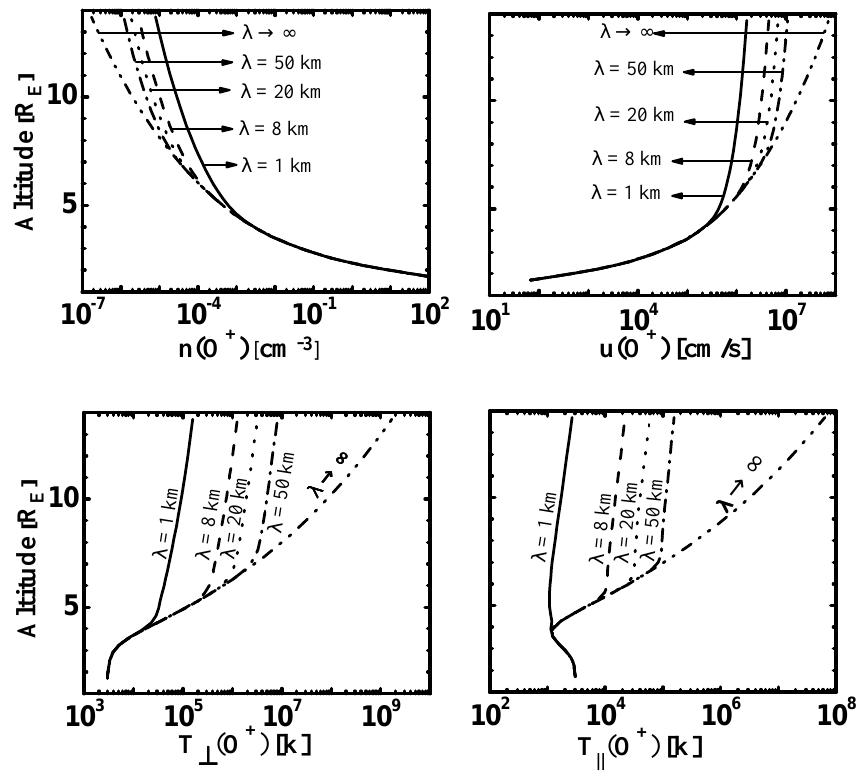
Fig. 3. Altitude profiles of the lower order O + moment for different electromagnetic turbulence wavelengths ( λ ⊥ ) . The wavelengths considered here are λ ⊥ → ∞ (double-dotted dashed line), λ ⊥ = 50km (dotted dashed line), λ ⊥ = 20km (dotted line), λ ⊥ = 8km (dashed line), λ ⊥ = 1km (solid line). The O + moments considered here are: density n( O + ) (top left), drift velocity u( O + ) (top right), perpendicular temperature T ⊥ ( O + ) (bottom left), and parallel temperature T k ( O + ) (bottom